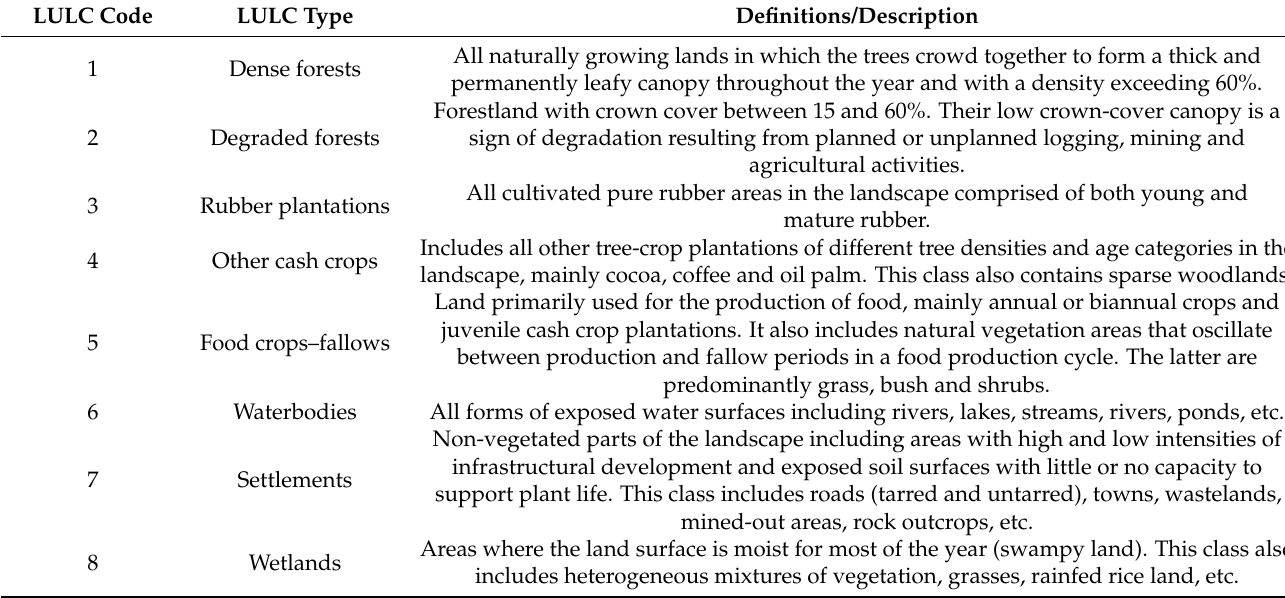
Table 1. LULC definitions used in this